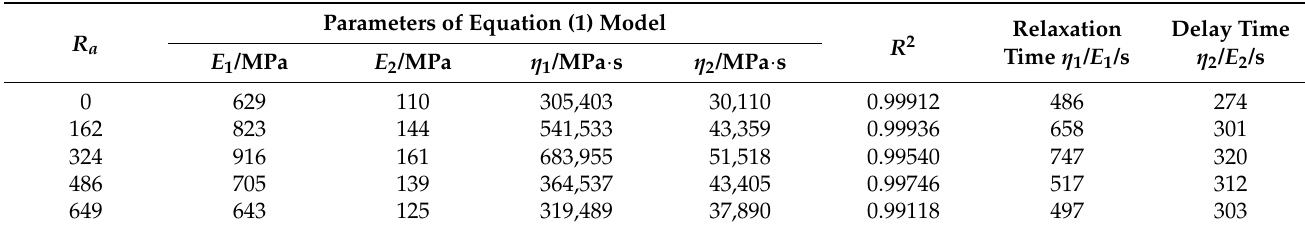
Table 4. Equation (1) model parameters of asphalt composite concrete with different R a